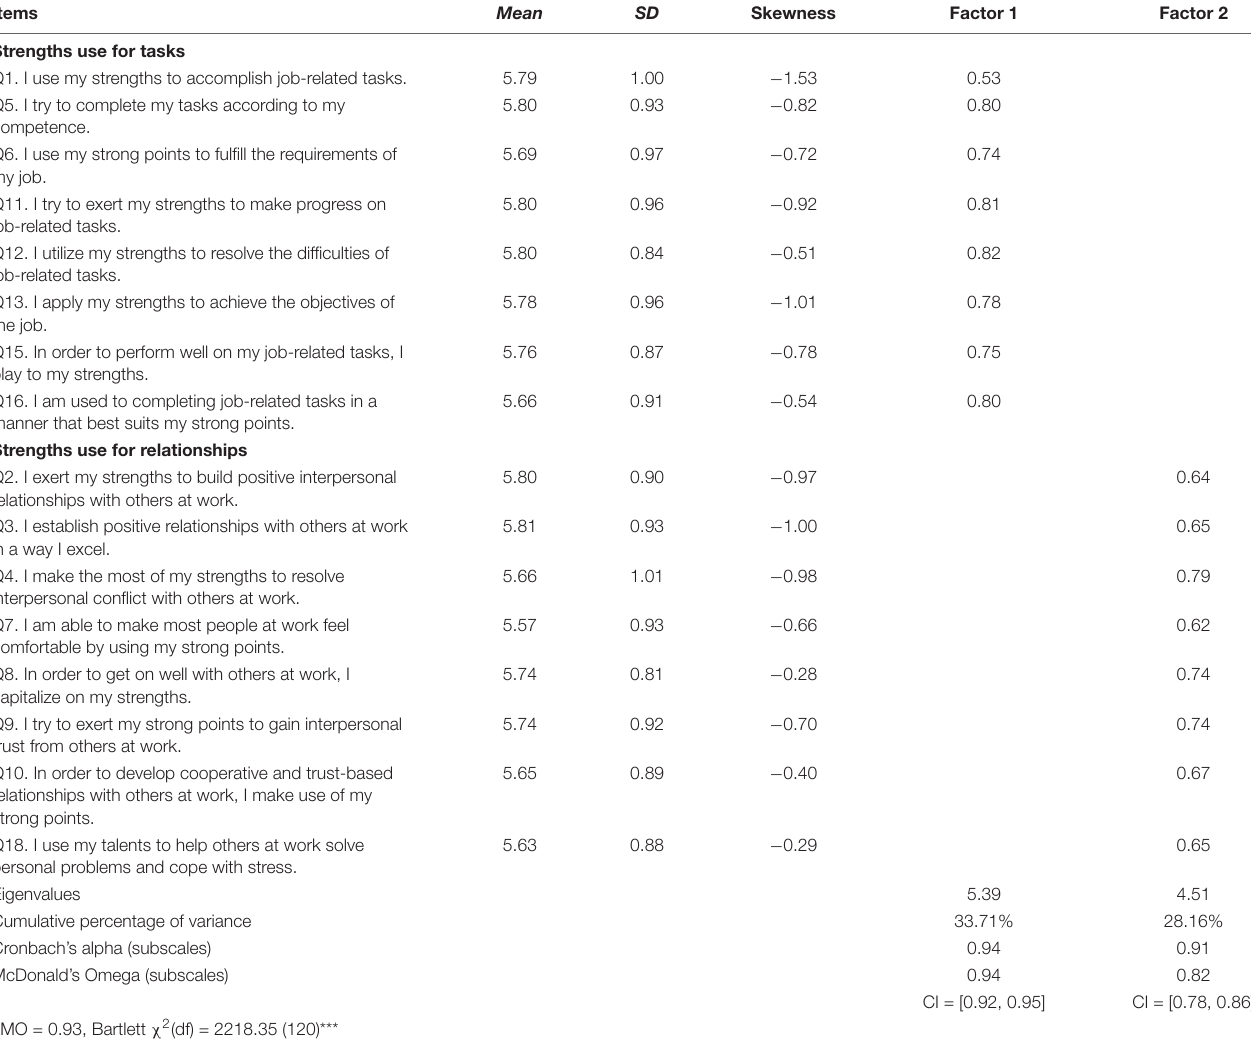
TABLE 1 | Scale items statistics and factor loadings from exploratory factor analysis. Items Mean SD Skewness Factor 1 Factor 2 Strengths use for